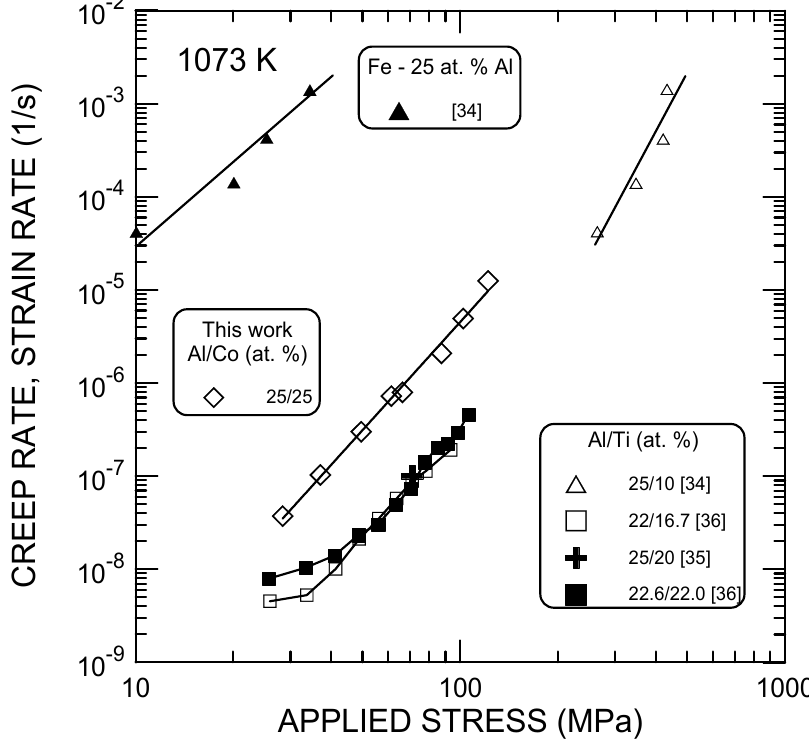
Figure 6. Comparison of creep rate / strain rate variation with applied stress for the present alloy, binary Fe–Al alloy and Fe–Al–Ti alloys at 1073 K.